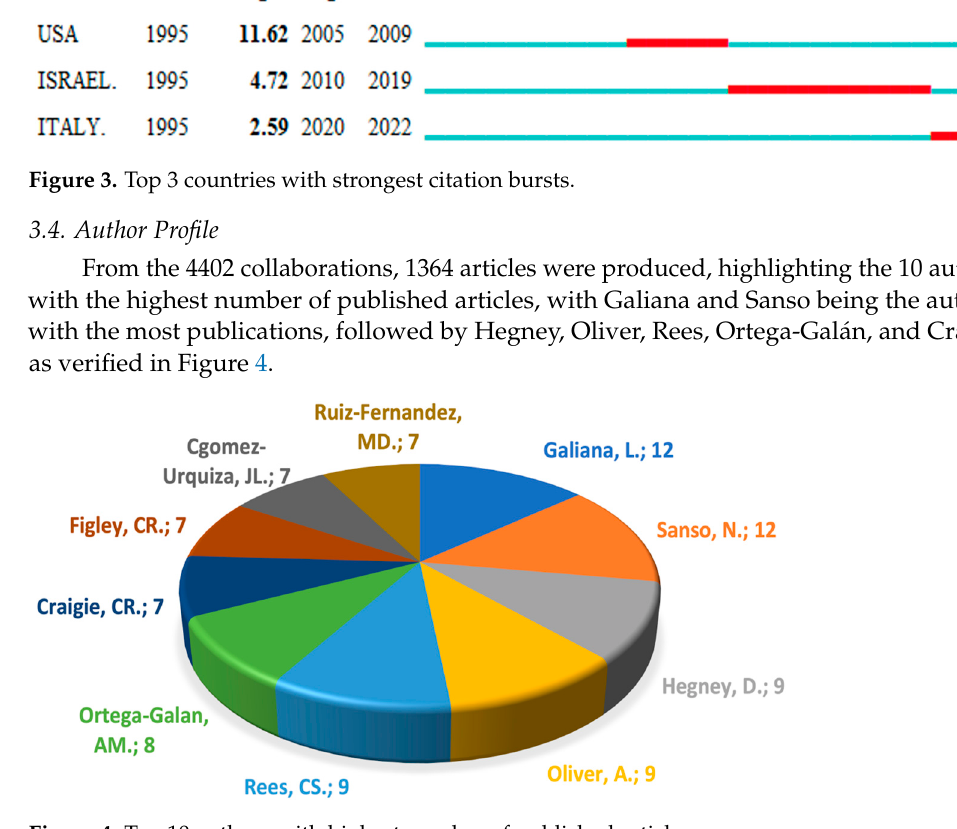
Figure 4. Top 10 authors with highest number of published articles.